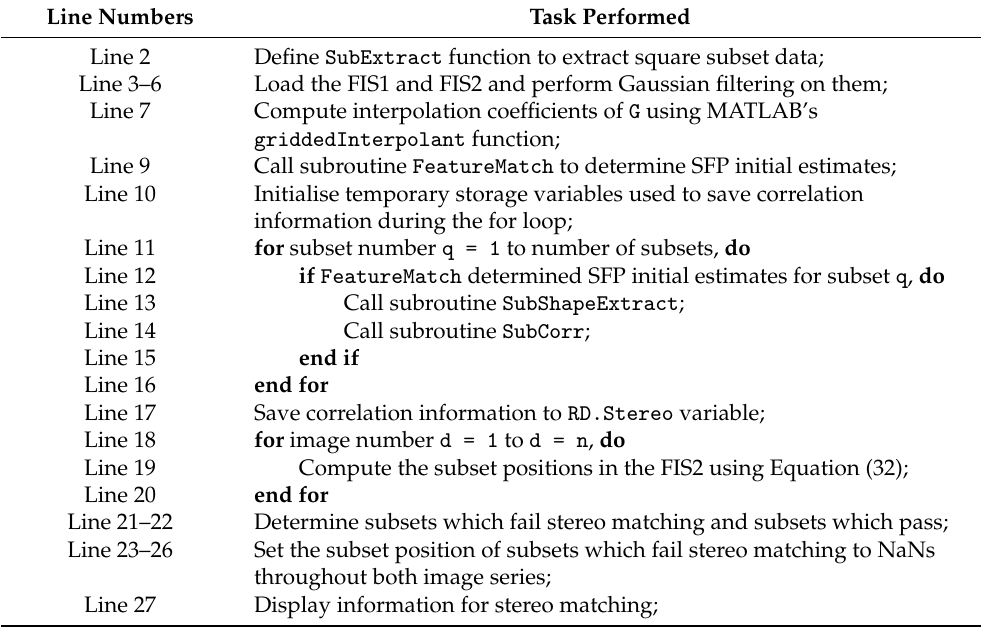
Table 9. StereoMatch algorithm